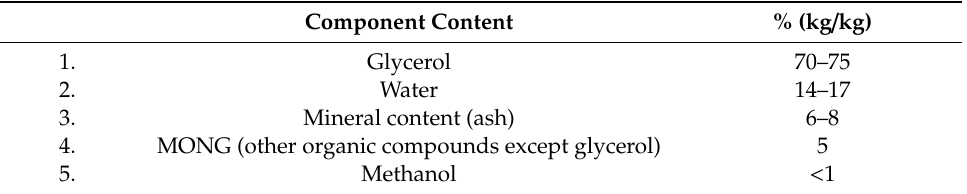
Table 2. Typical composition of technical glycerol